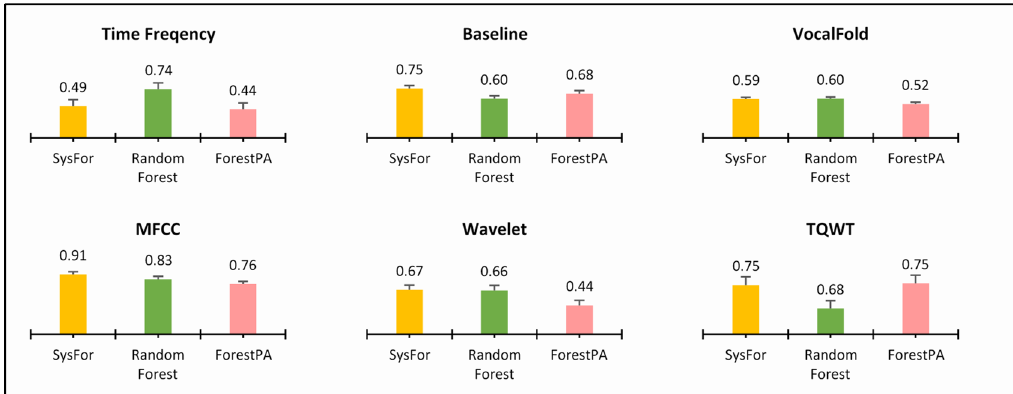
Figure 6. Highest specificity of decision forest algorithms with minimum number of trees on various feature of Istanbul acoustic signal dataset.